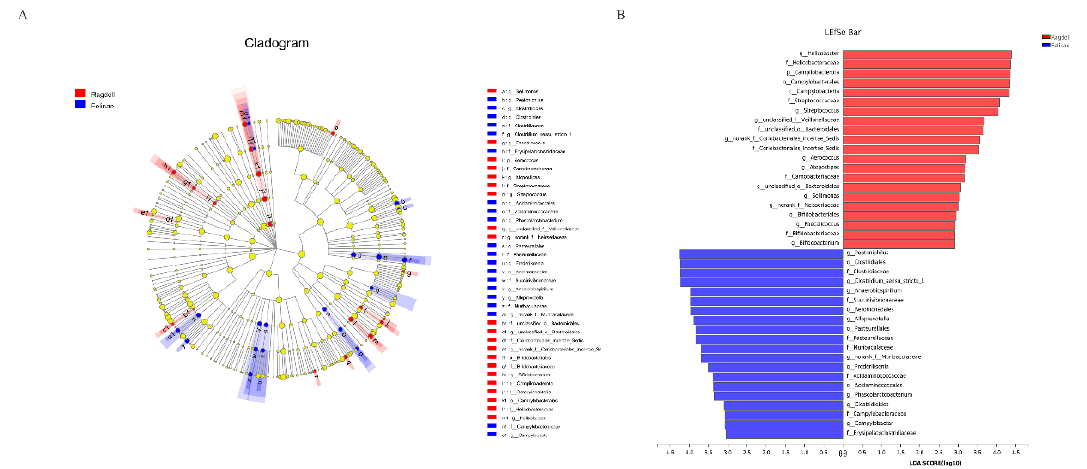
Figure 5. The linear discriminant analysis effect size (LEfSe) reveals the most featured bacterial taxa in the feline gut microbiota. The cladogram represents the discriminative features of the taxa between the two groups ( A ). The LDA coupled with effect size measurements identified the most differentially abundant taxa between the two groups ( B ).